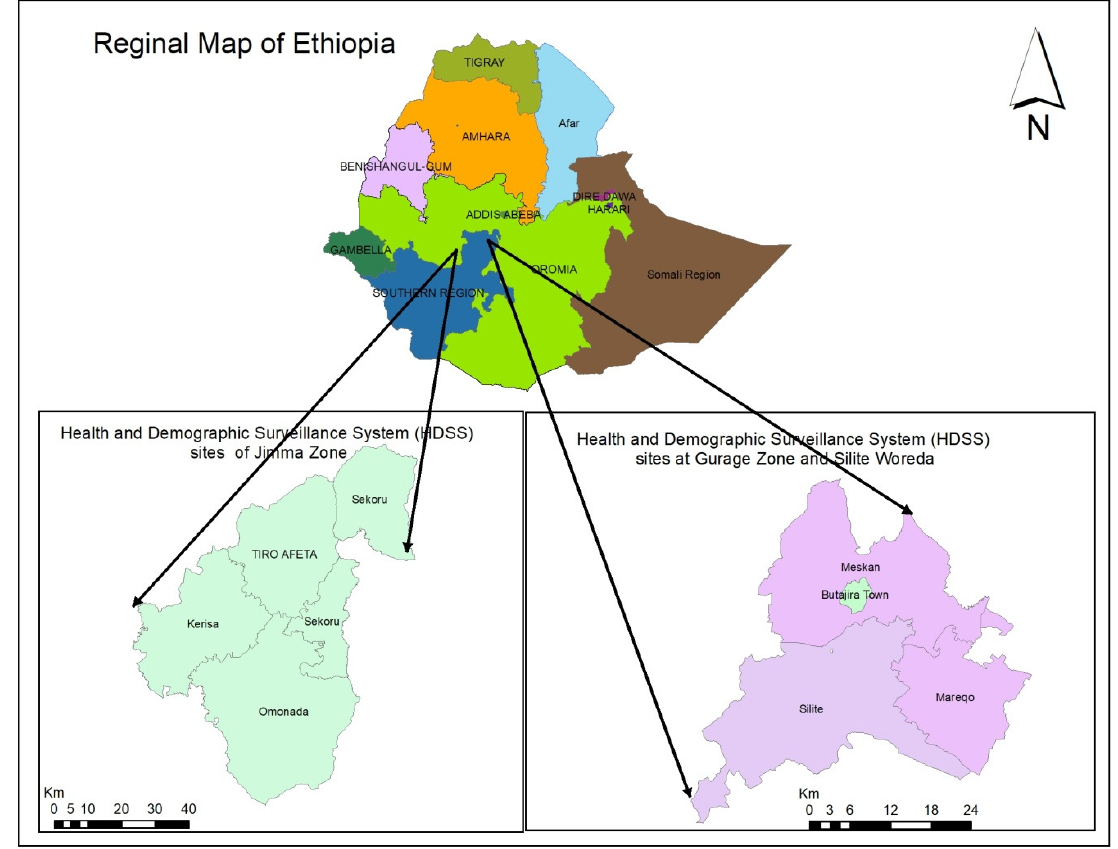
Figure 1. Map showing the location of the sites within Ethiopia. The Gilgil Gibe HDSS ( left ) is lo- cated in the Jimma zone of the Oromia region, whereas the Butajira HDSS ( right ) is located in the Gurage zone and Silite woreda of the Southern Nation and Nationality Region (SNNPR).